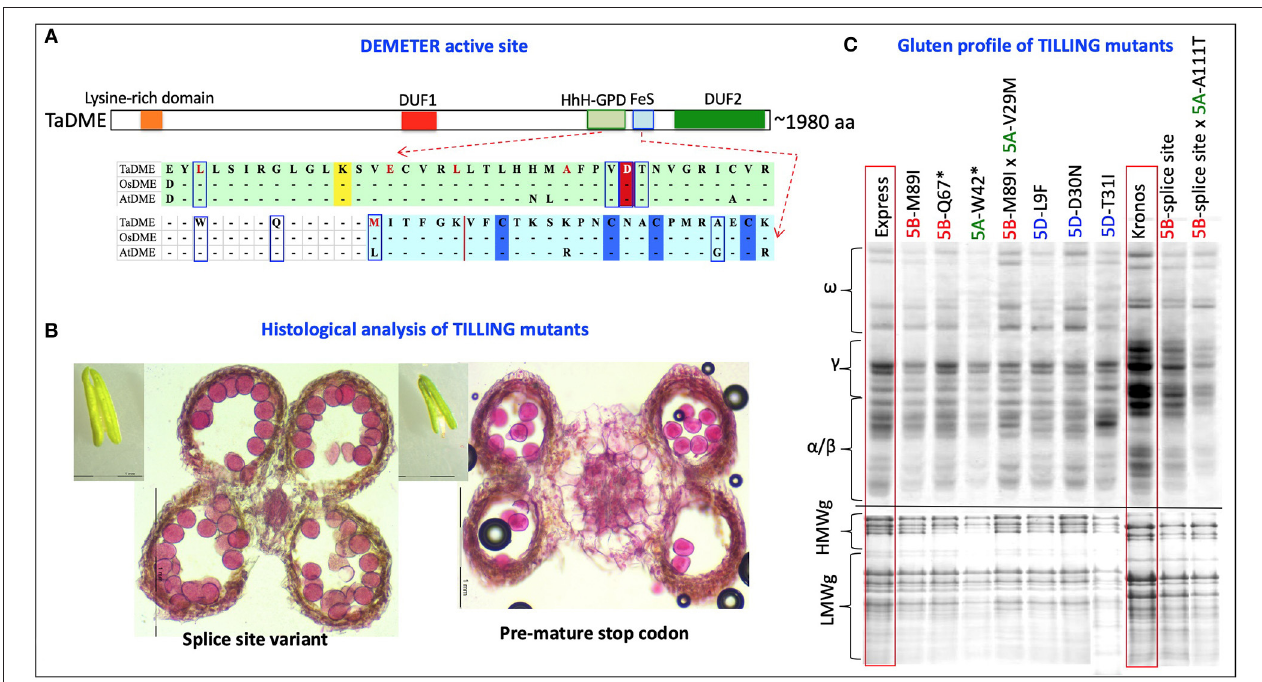
FIGURE 4 | TILLING mutants of the Wheat DEMETER homoeologues. (A) Diagrammatic representation of the mutations identified in the active site of wheat DEMETER homoeologues. The glycosylase domain, including helix-hairpin-helix-Gly/Pro-rich loop followed by a conserved aspartate and iron-sulfur cluster, were highlighted by light green and light blue colors. Conserved lysine “K”, aspartic acid “D” and cysteine “C” residues are, respectively, highlighted by yellow, red, and blue colors. A dashed line indicates splice site variants. Mutations analyzed further for validation of mutant genotype and zygosity are boxed or underlined in splice site variants. Bold red font = mutations previously reported in Arabidopsis and shown to disrupt enzyme activity (42). (B) Differences were observed between the anthers and pollen grains of a splice site variant (left, 33,412) and a mutant with a premature stop codon (right, 36,505). Size of anthers was reduced to almost half in the mutant, “36505” carrying a stop codon in A sub-genome DEMETER homoeologue in “Kronos” background. To determine pollen viability, transversely sectioned anthers and isolated pollen grains were stained with a solution containing 10mL of 95% alcohol, 1mL of malachite green, 25mL of glycerol, 5mL of acid fuchsin, 0.5mL of Orange G, and 4mL of glacial acetic acid in 54.5mL of distilled water. Pollens showing deep magenta color represent viable pollens. (C) Gliadin and glutenin profiles of selected TILLING mutants (M 3 ) in “Express” and “Kronos” background showing reduced accumulation of gliadins and LMW glutenins in their grains. Two selected F 2 lines from the genetic cross of “A” and “B” subgenome DEMETER mutants were also analyzed for their gluten profiles. *Premature stop codon.